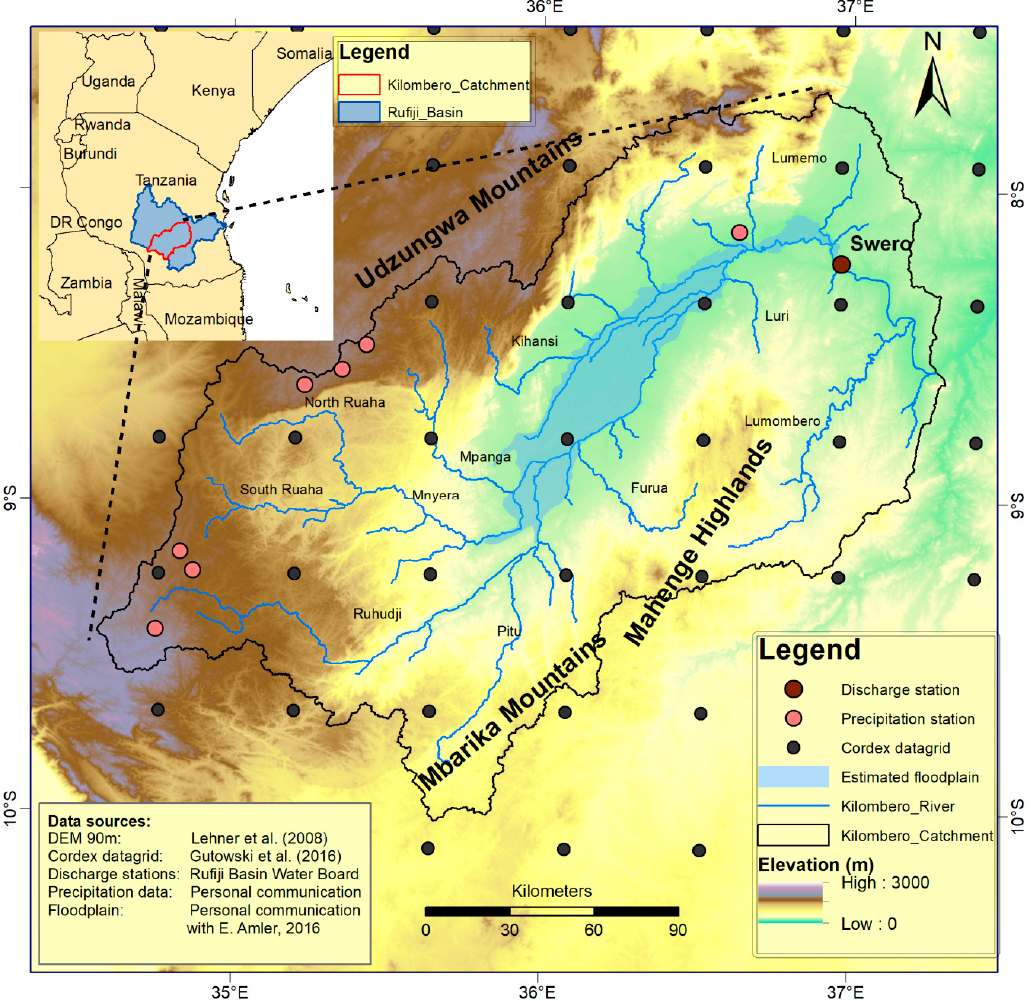
Figure 1. Overview map of the study area, including locations of available precipitation and discharge stations (Swero), as well as the 0.44 ◦ Coordinated Regional Downscaling Experiment (CORDEX) Africa grid. The estimated floodplain area is based on visual interpretation of Landsat images (modified after Näschen et al. [23]).